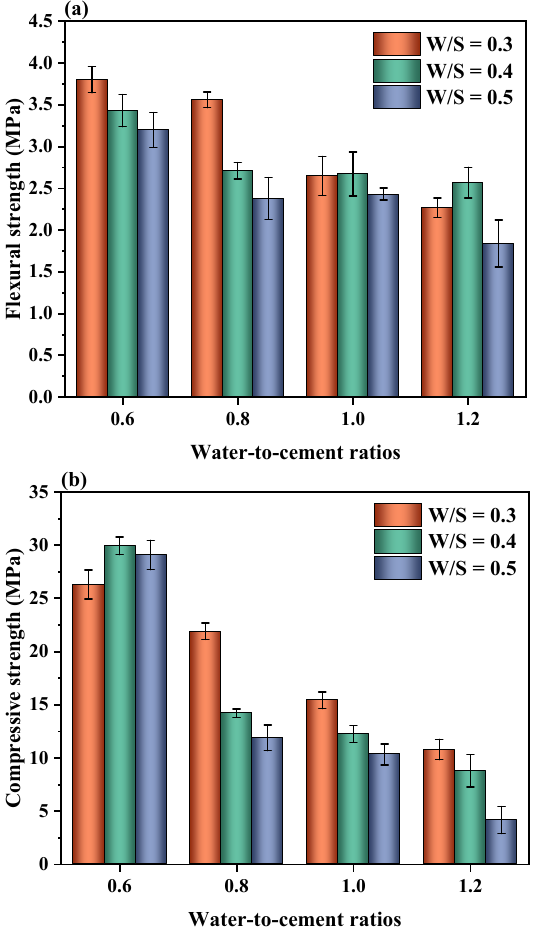
Figure 4. Flexural strength ( a ) and compressive strength ( b ) of hardened CPBs at 28 d. As shown in Figure 4, the strength of CPB is inversely proportional to the W/S of mixtures. The flexural and compressive strength values increase as the solid contents increase. This can be attributed to the cement content per unit volume and total porosity within CPB [16]. The relatively high solid contents clearly increase the strength of CPBs and correspond to lower water contents and the decreased fluidity of fresh CPBs (Figure 3a). In all cases, the mechanical properties of CPB are positively correlated to the W/C ratios, which can be attributed to the higher capillary pore volume originating from the free water in the mixtures. With the increasing W/S, the cement contents per unit volume increase. However, only compressive strength values at W/C of 0.6 show an increasing trend with the cement contents at different W/S ratios, which indicates that total porosity is the main factor influencing the mechanical properties rather than the cement and hy- dration product content in these cases. Moreover, our previously published work [21], indicated that the addition of PAM has a retarding effect on the hydration of the cement, which can lead to a reduction in strength within certain limits. Meanwhile, Chen et al. [17] also identified that PAM inhibited the strength development of specimens cured for 28 days. On the other hand, OPC content has a significant effect on the mechanical behavior of CPB specimens. As expected, increasing the cement content results in a higher CPB compressive strength (Figure 4b). The highest strength was obtained using the W/C of 0.6 proportion, which is two to three times higher than the strength obtained using the W/C of 1.2 proportion. Güneyisi et al. [25] demonstrated that reducing the water-to-binder ratio significantly increased the compressive strength. Notwithstanding these potential bene- fits, increasing the amount of OPC will increase the operating costs of CPB, thus in order